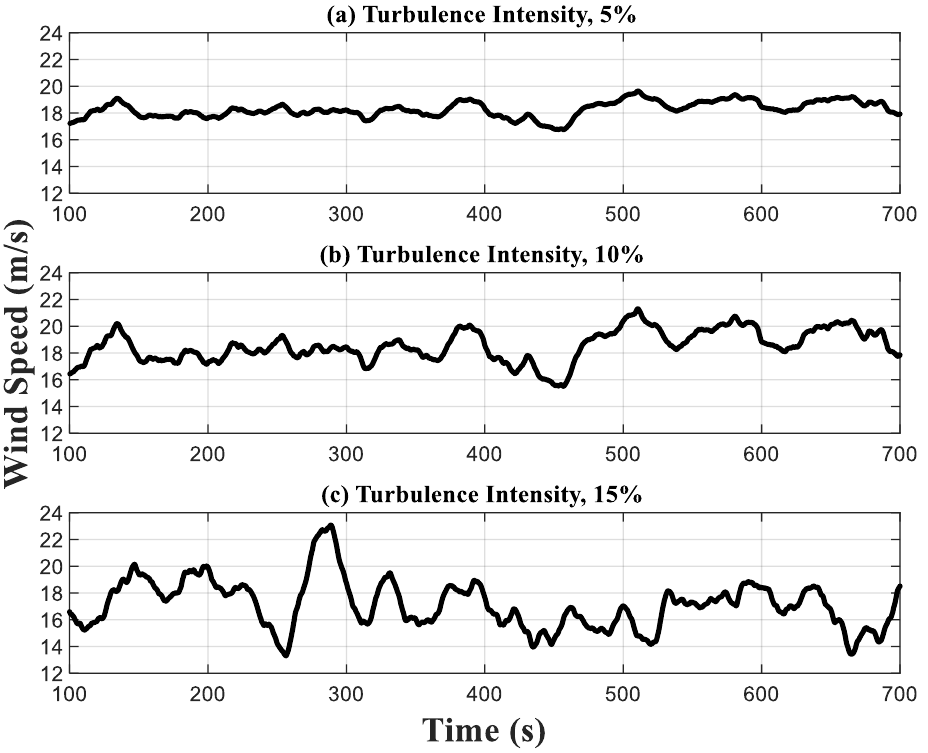
Figure 3. Wind speed with a mean value of 18 m/s: ( a ) turbulence intensity of 5%, ( b ) turbulence intensity of 10%, ( c ) turbulence intensity of 15%.